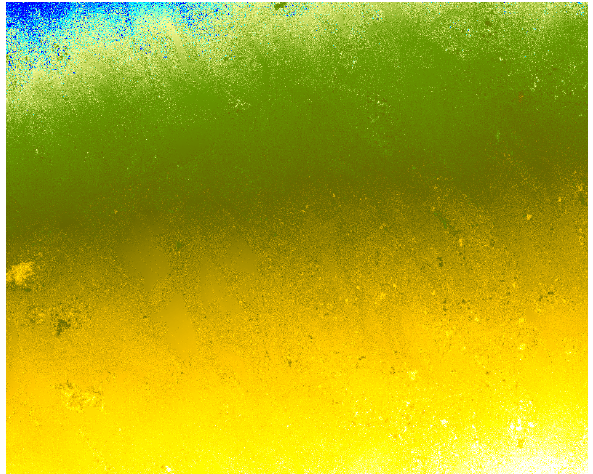
Figure 12. DEM generated from the Interferogram of the Figure 11